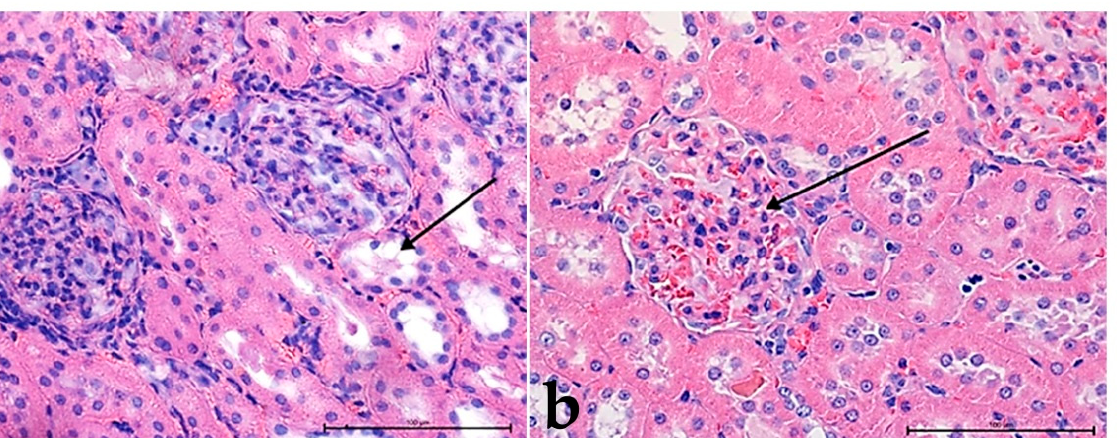
Figure 2. The changes in the structure of the kidneys in groups: II ( a ), IIa ( b ), III ( c ), IIIa ( d ). Glomeruli with different urine content (black arrow). Note the presence of leukocytes in the kidney parenchyma in IIa group ( b ) (red arrow). H&E staining. Mag. 400×. Bar scale 100 µm. Among the three fractions tested, the most potent activity enhancing urogenesis with numerous sites showing the arrested vascular flow and increased activity of connective tissue cells were observed in groups: IV (Figure 3a), IVa (Figure 3b), Va (Figure 3d), VI (Figure 3e) were the weakest in group V (Figure 3c). In group VIa , the outlook was similar, but it seems that the proximal and distal tubules were less filled with urine (Figure 3f). The toxic effect was observed as venous stasis with the presence of proliferating fibro- blasts. Moreover, extensive lymphocyte infiltrates in large vessels’ vicinity were particu- larly noticeable in group IVa (Figure 3b).